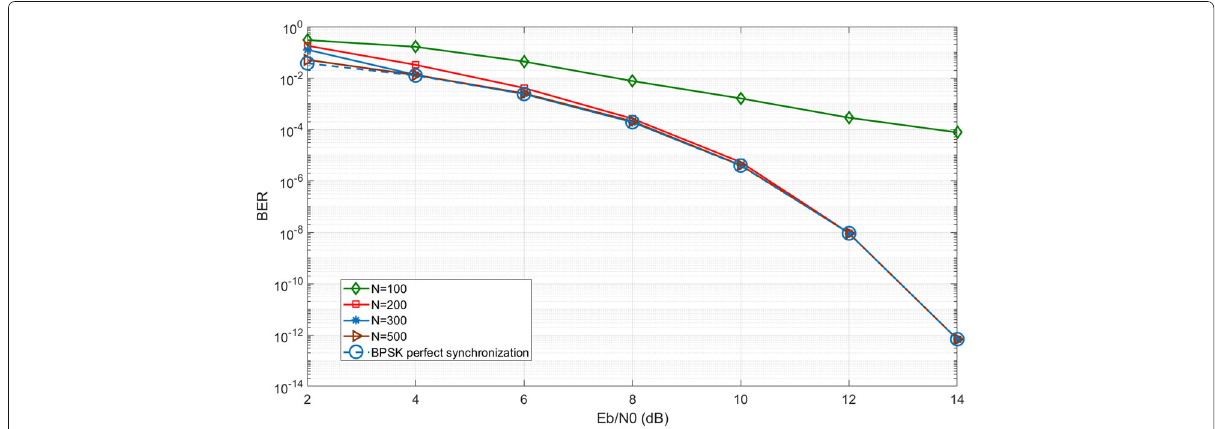
output of TED block is averaged to calculate μ in each iteration, and then the SRC block recalculates the samples based on the estimated timing offset. As can be seen from Fig. 7, in this scenario, ignoring NSRO and using tradi- tional timing recovery loop does not work and the BER tends to 1/2 regardless of SNR value. Unlike traditional timing recovery, the performance of our proposed algo- lower bound has been plotted with the assumption of per- of BER = Q ( 2 E b / N 0 ) .